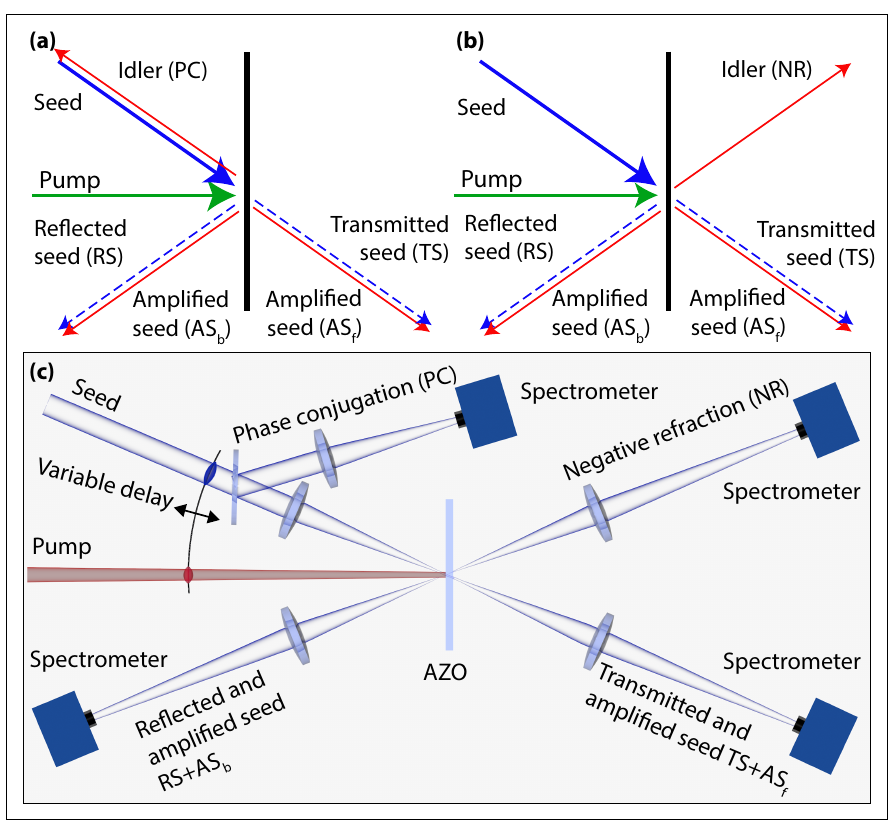
Figure 1. ( a , b ) describe the two four-wave mixing processes that generate the PC and NR signals, respectively. The pump beam is illustrated with a green arrow while the input seed is shown with a blue arrow. Red arrows show the result of the parametric amplification process, while blue dashed arrows show the linear reflection and transmission. For each of these two four-wave mixing processes, the seed field is amplified and emerges along both the transmitted and reflected directions. ( c ) Sketch of the experimental setup. Pump and seed fields have the same wavelength (1400 nm) and vertical polarisation. The seed is overlapped to the pump with an angle of (cid:39) 6 ◦ . The delay between the pump and seed pulses is controlled by a delay line (not shown). A spectrometer is used to collect the radiation emerging along the direction of the seed reflection and transmission (RS + AS b and TS + AS f ), as well as to characterise the PC and